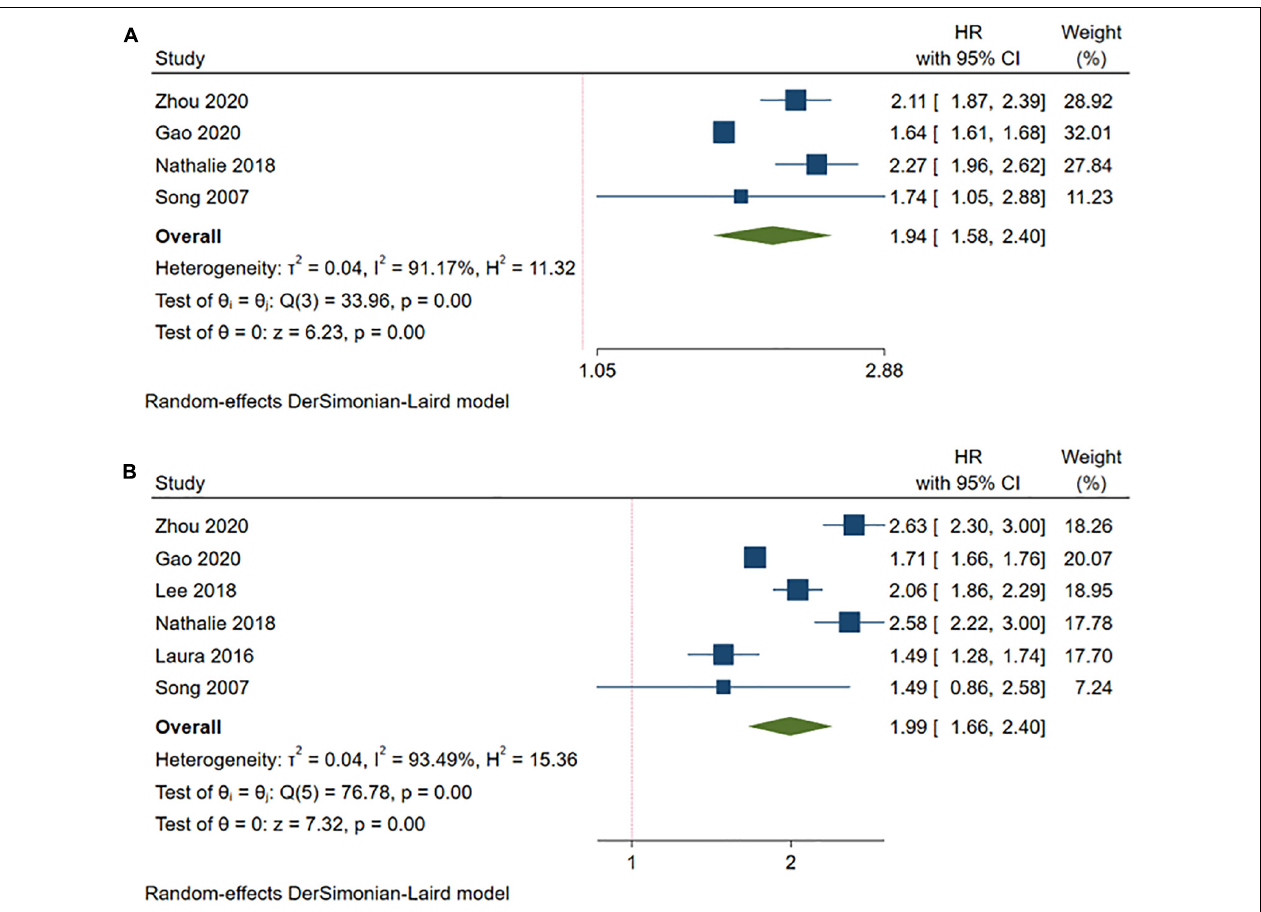
FIGURE 4 | Meta-analysis of the risk of stroke in the MUOW/MUO phenotypes compared with the MHNW phenotypes. (A) MUOW phenotypes; (B) MUO phenotypes. MHNW, metabolically healthy normal weight; MHOW, metabolically healthy overweight; MHO, metabolically healthy obese; MUNW, metabolically unhealthy normal weight; MUOW, metabolically unhealthy overweight; MUO, metabolically unhealthy